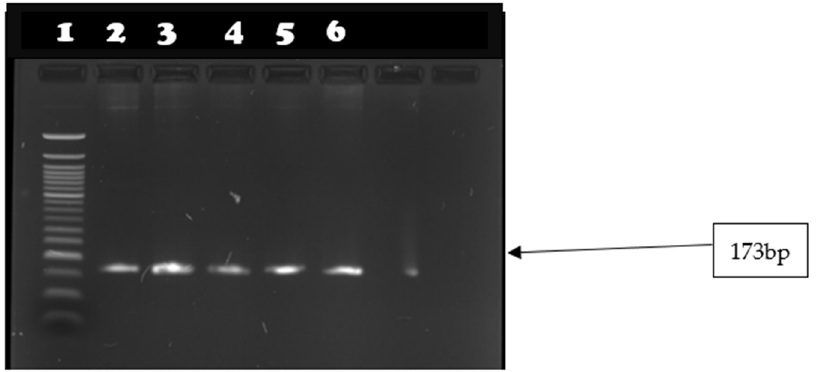
Figure 5. Image showing seh gene amplicons observed on agarose gel. Lane 1: 50 bp DNA ladder; lanes 2–6 show amplicon sizes for samples that were positive for seh gene (165 bp). Table 5. PCR amplification results for S. aureus methicillin-resistance and enterotoxin genes.